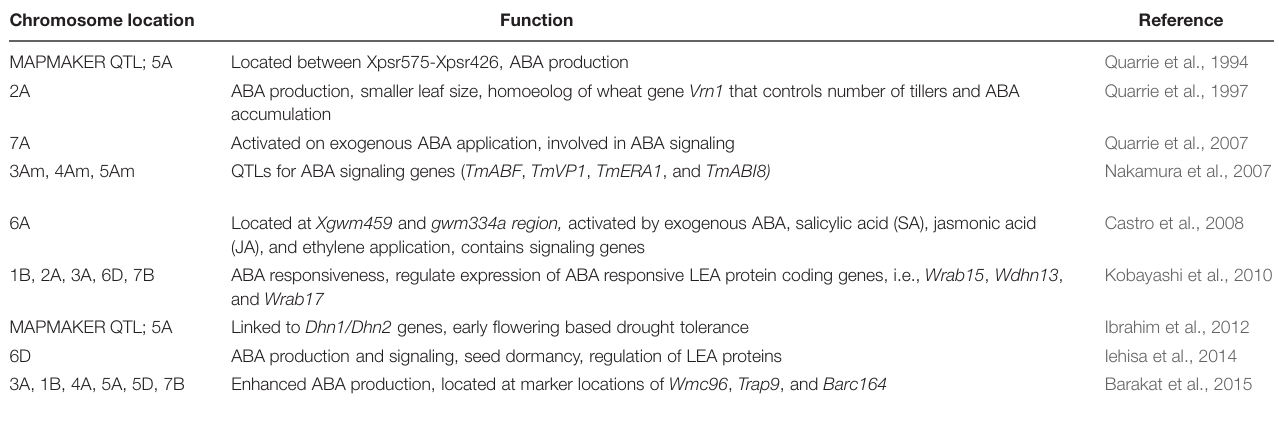
TABLE 3 | Quantitative trait loci (QTLs) mapped for drought signaling molecules in